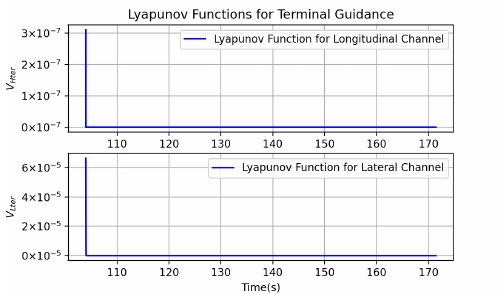
Figure 17. Lypunov functions of terminal